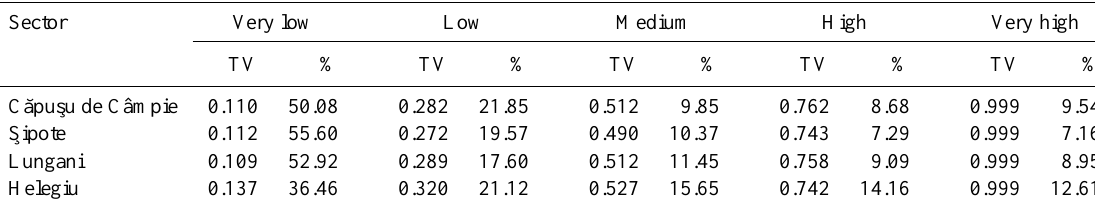
Table 5. Upper thresholds values (TV), derived by Jenks’ method, and percentages of landslide susceptibility classes from the total area of each sector. Sector Very low Low Medium High Very